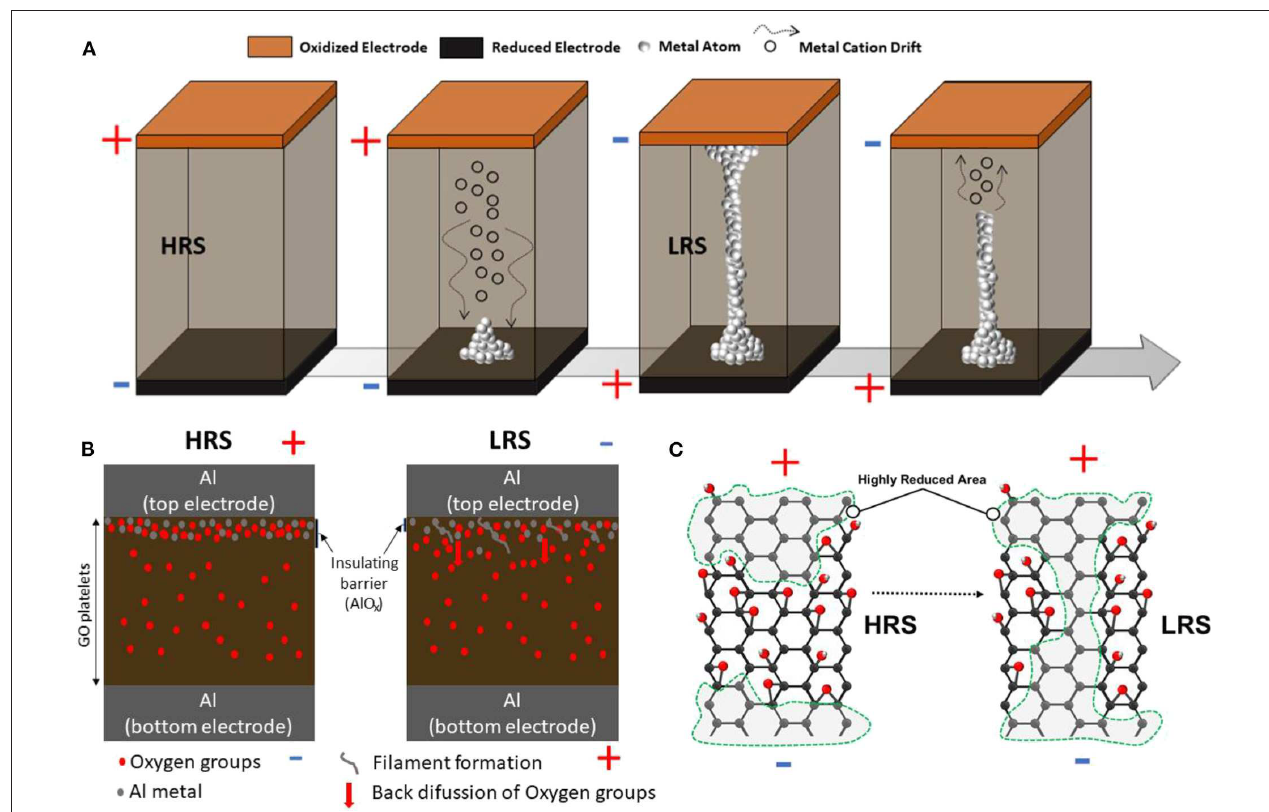
FIGURE 1 | (A) Conceptual representation of the formation and annihilation of a metallic filament responsible for the resistive switching according to the metallic filamentary. (B) Model of the resistive switching in graphene oxide [adapted with permissions from Jeong et al. (2010)]. Copyright 2010 American Chemical Society. The as-fabricated device is in the HRS due to the insulating top interface layer formed by a redox reaction between Al and the GO film; The LRS state is induced by formation of filaments at the top interface layer due to oxygen ions diffusion by an external negative bias on the top electrode. (C) The GO surface is characterized by the combination of sp 2 (green dashed areas) and sp 3 domains. At a nanoscale level, the sp 2 regions present high-conductivity but they are interrupted by low-conductivity sp 3 domains rich in functional groups. When a current is flowing, the high resistivity of the sp 3 domains creates local large gradients of electrostatic potential resulting in strong local electric fields. Joule heating of the high resistivity region triggers the drift of the oxygen containing groups (migration of functional groups), creating eventually a conductive